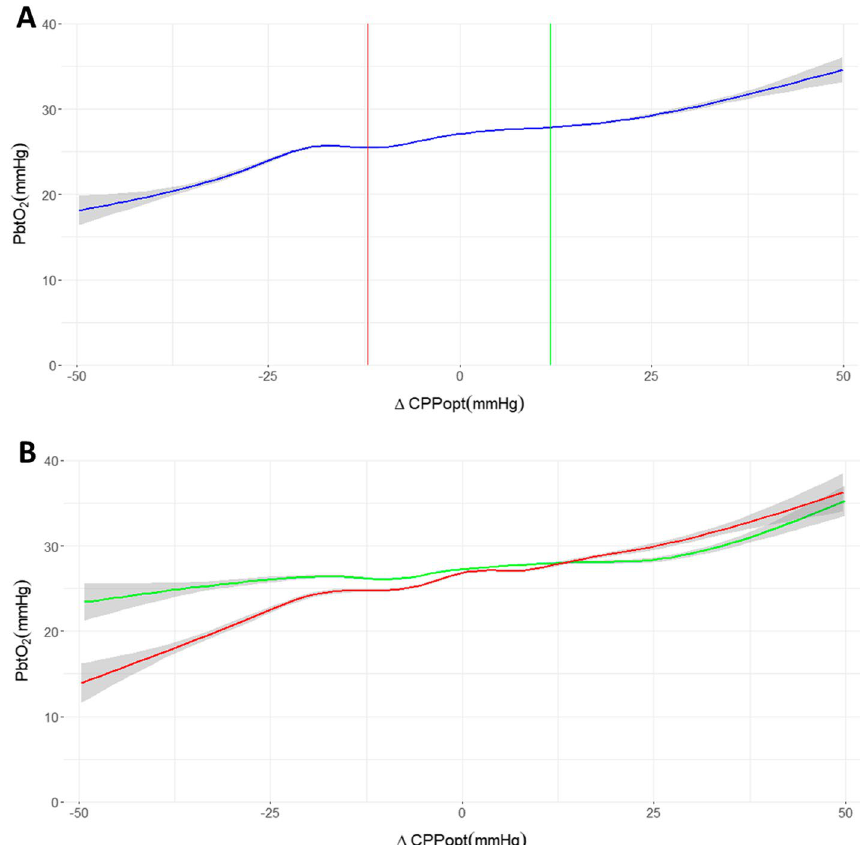
Fig. 2 The relationship between brain tissue oxygenation (PbtO 2 ) and difference from optimal cerebral perfusion pressure (ΔCPPopt) is seen in A . The median ΔCPPopt value associated with the lower limit of reactivity (red) and upper limit of reactivity (green) are also plotted. In B , this relationship is examined when cerebrovascular pressure reactivity is intact (green) as compared to when it is disrupted (red). Note that 95% confidence intervals for all tracings are shown in